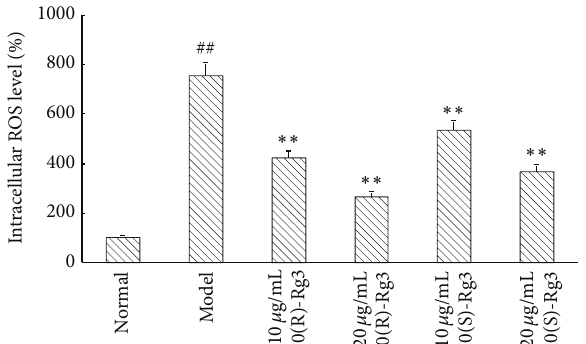
Figure 8: Ginsenoside Rg3 reduced the intracellular ROS formation in SK-N-SH cells. ## 𝑃 < 0.01 versus normal group and ∗∗ 𝑃 < 0.01 versus model